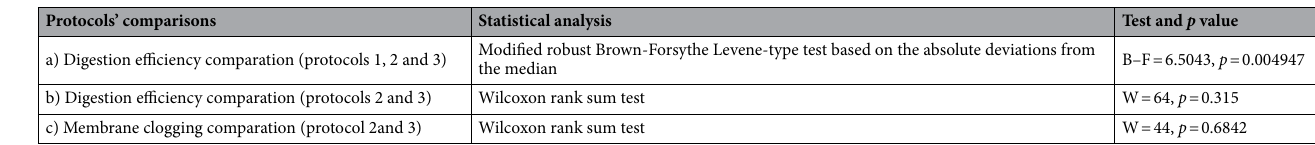
Table 1. Statistical analysis with Leven test (B-F) and Wilcoxon rank sum test (W) and p-value of all protocols comparations in Sabella spallanzanii samples. A p < 0.05 in the B-F test (a) indicate a non-homogeneity of